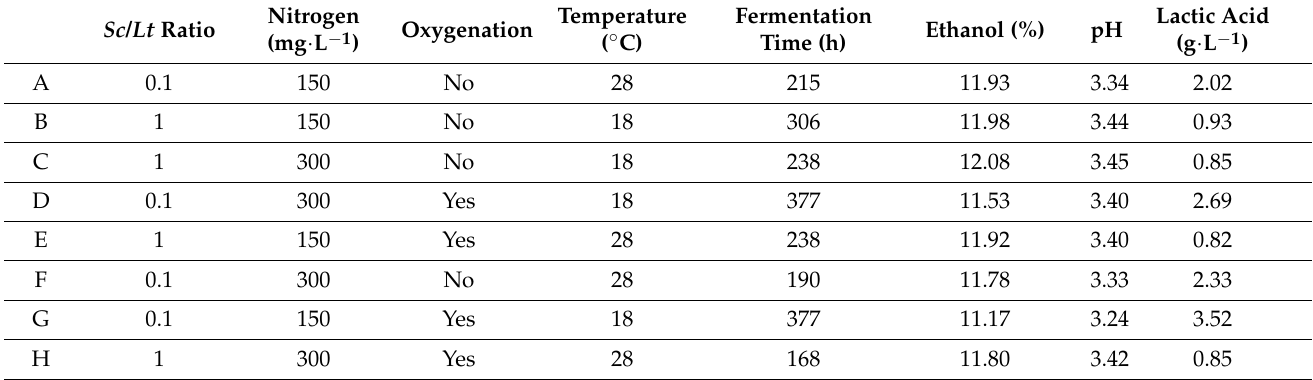
Table A2. Quantitative data related to fermentation in the different conditions of the experimental design (A to H): fermentation time (time of total consumption of initial sugars), ethanol concentration, pH, and lactic acid concentration at the end of the